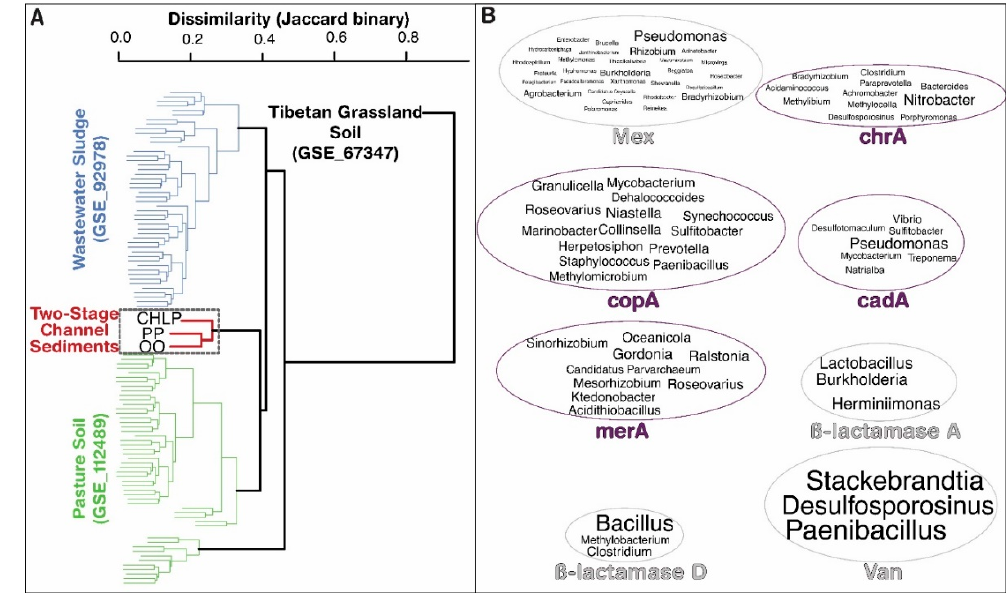
Figure 5. Antibiotic resistance and metal homeostasis gene probes were cross-detected in two-stage channels and other environments. ( A ) Hierarchal clustering analysis was used to compare different GeoChip sets based on the shared gene probes using the binary Jaccard index. Only one sample from a study of Tibetan restored grasslands is shown. ( B ) Indicator species analysis of antibiotic resistance and metal homeostasis gene probes for two-stage channel sediments with word area scaled according to the maximum number of these indicator gene probes associated with each genus and normalized to the number of probes for that particular gene (larger font = more gene probes).